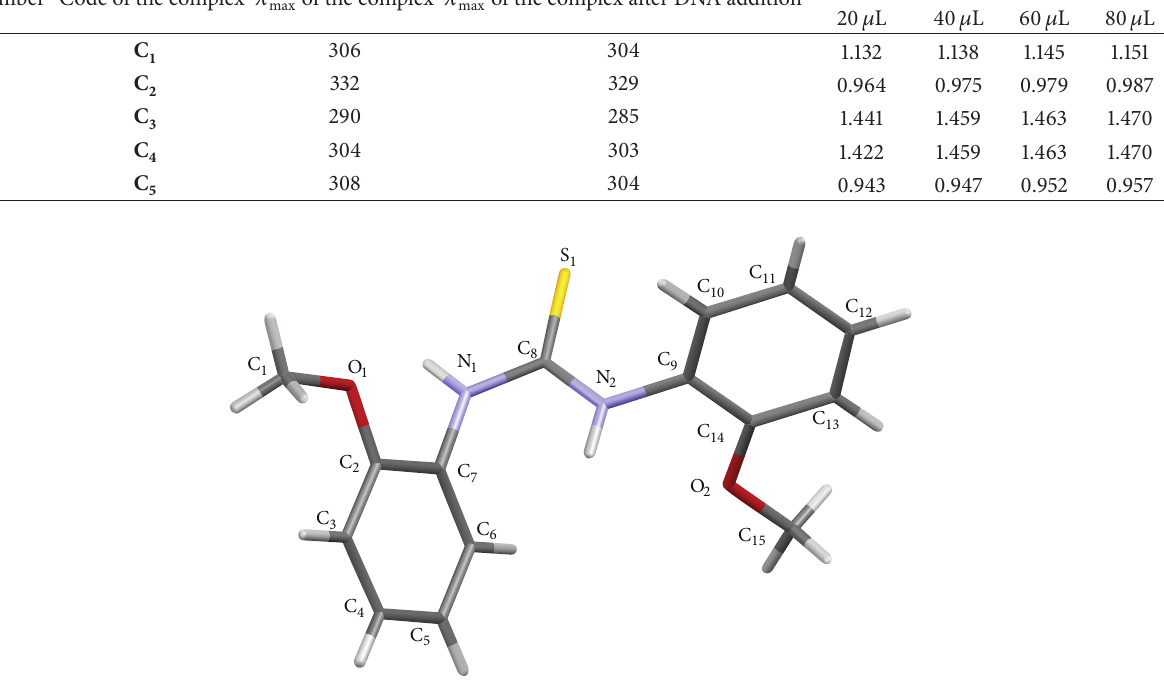
)(tu)Cl ]. 3 2 𝜇 L of DNA added and absorbance at 𝜆